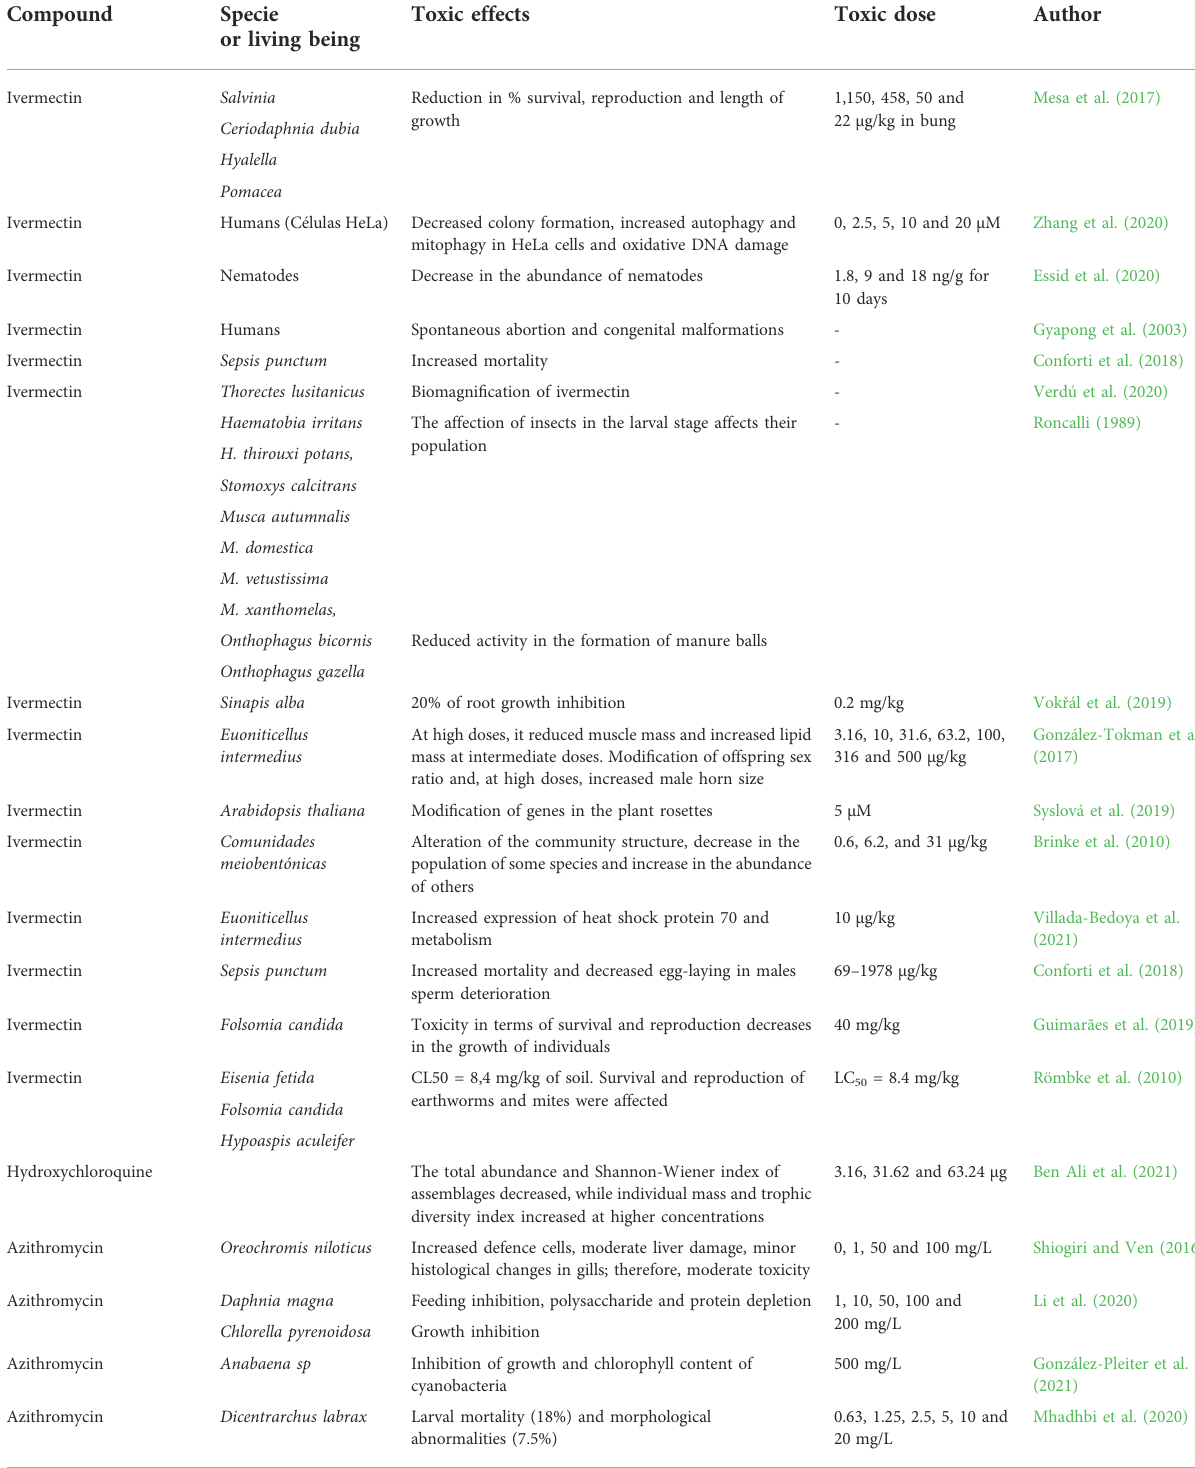
TABLE 3 Toxicological evaluations with main drugs used for Covid treatment